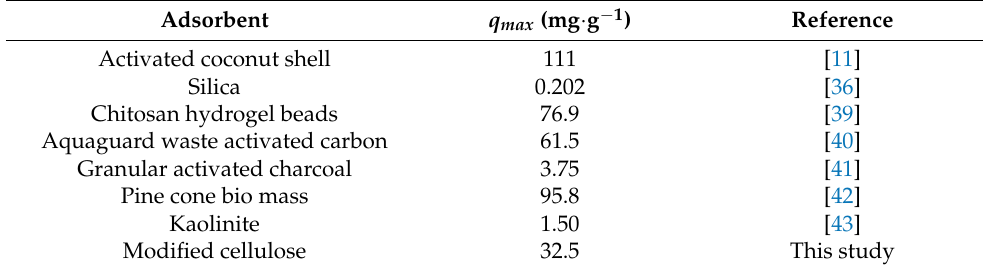
Table 5. Comparison of the adsorption capacity of different